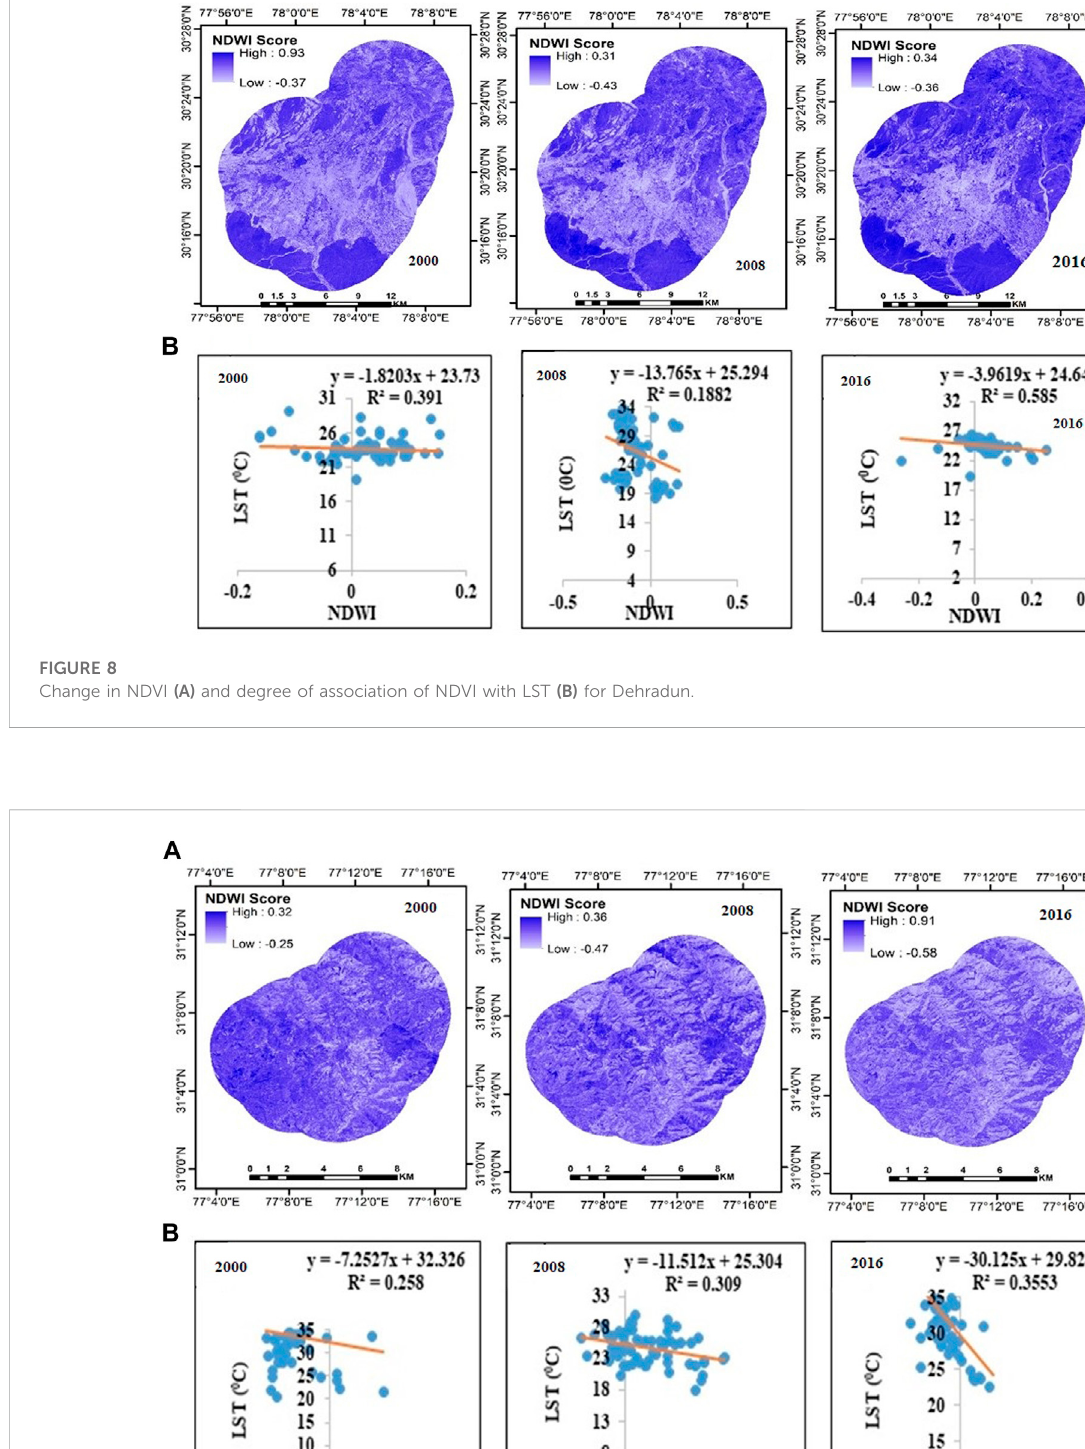
Frontiers in Environmental